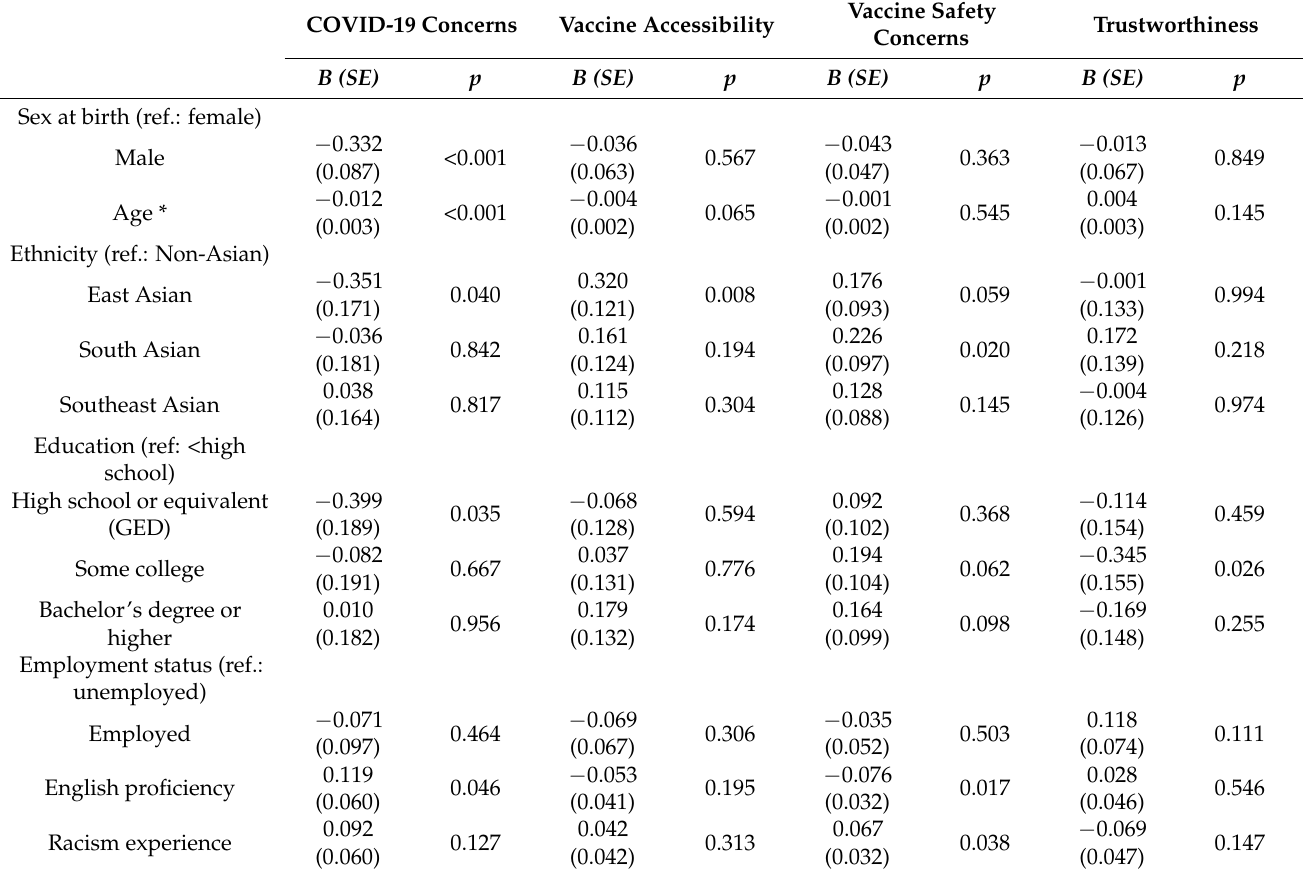
Table 3. Regression coefficients predicting COVID-19 concerns, vaccine accessibility, vaccine concerns, and trust in public health